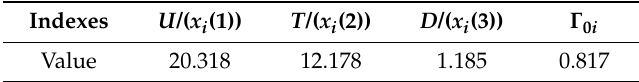
Table 11. Calculation results of different indexes using the optimal